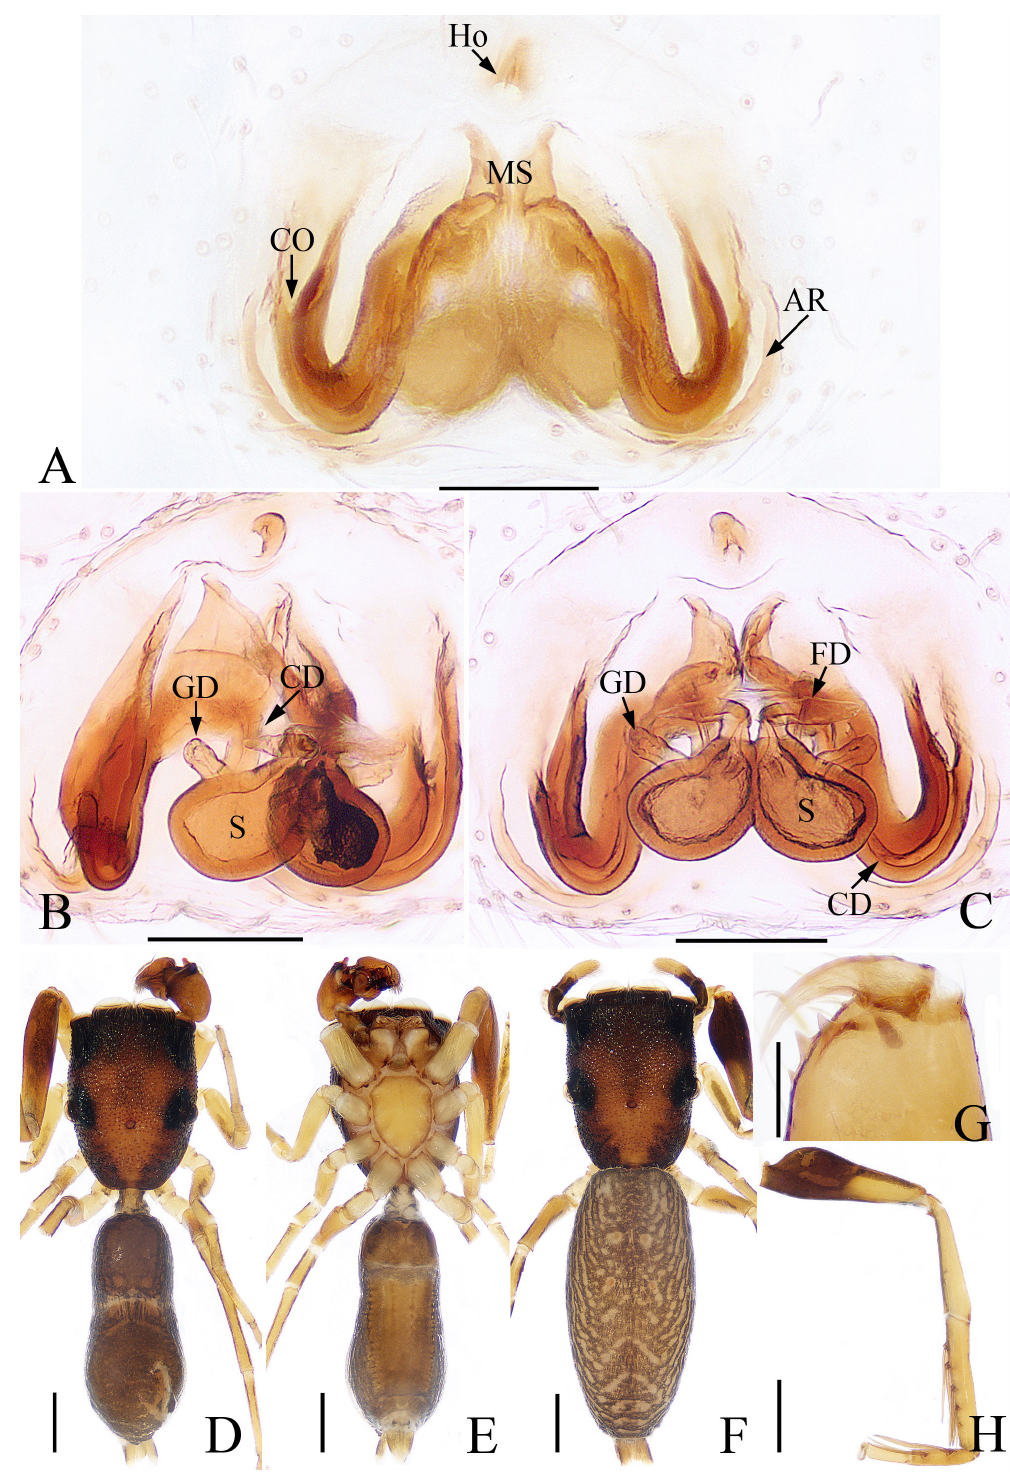
Fig. 8. Synagelides logunovi sp. nov. A–C, F . Paratype, ♀ (TRU-Salticid-0017). D–E, G–H . Holotype, ♂ (TRU-Salticid-0016). A . Epigyne, ventral view. B . Epigyne, dorsolateral view. C . Epigyne, dorsal view. D . Habitus, dorsal view. E . Habitus, ventral view. F . Habitus, dorsal view. G . Chelicerae, dorsal view. H . Leg I, prolateral view. Abbreviations: see Material and methods. Scale bars: A–C, G = 0.1 mm; D–F, H = 0.5